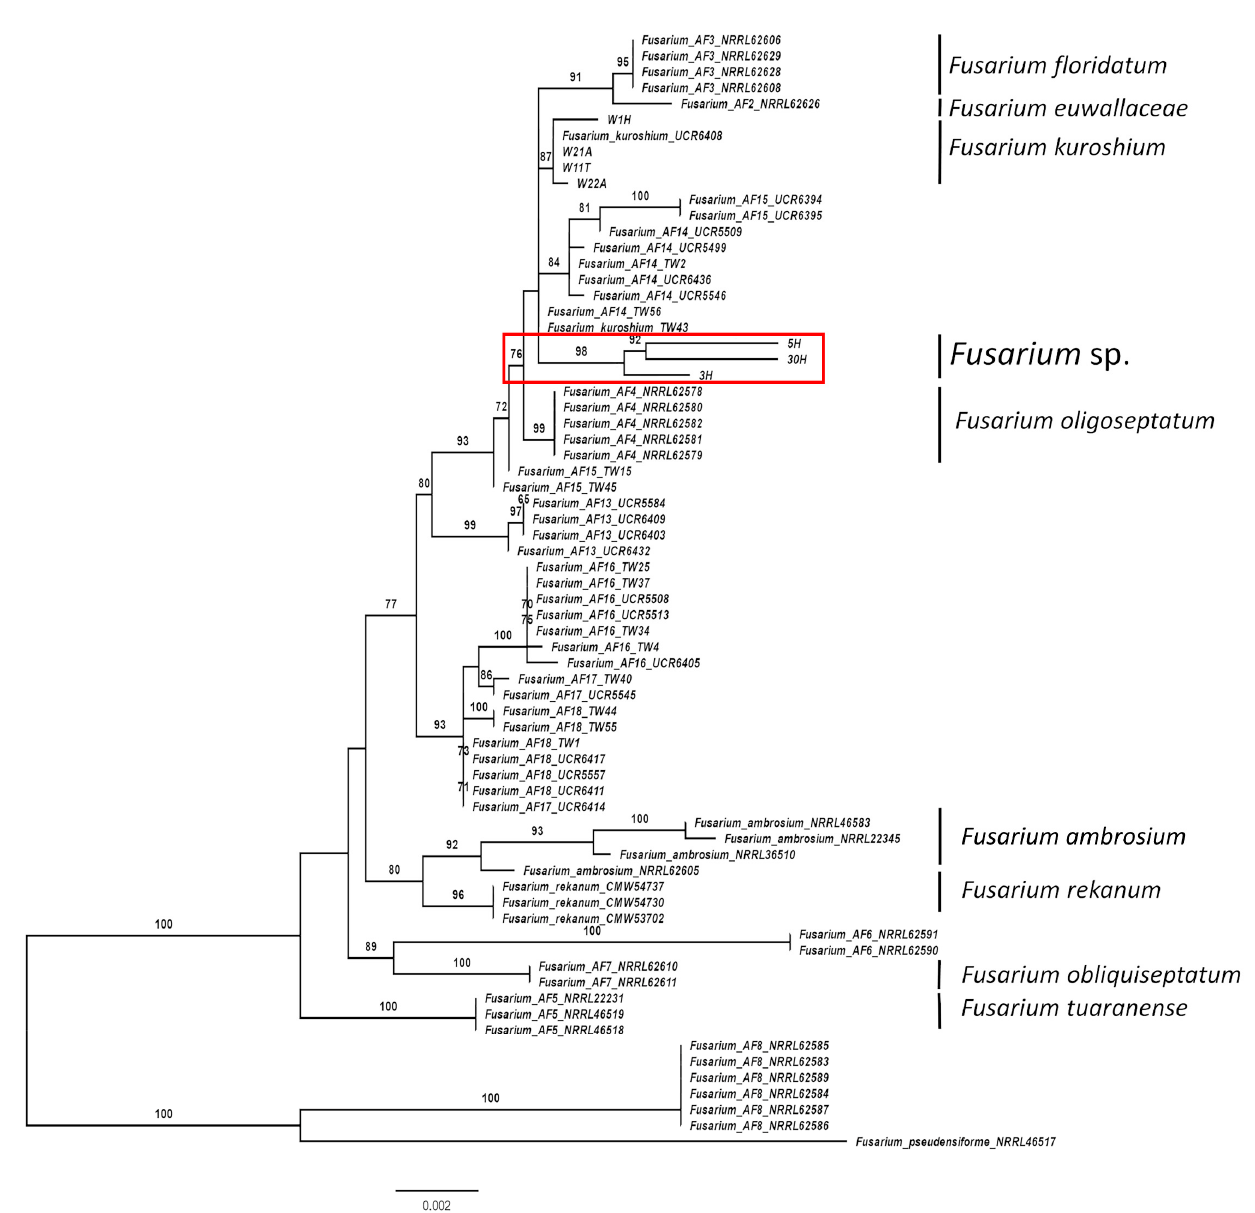
Figure 3. Multilocus phylogenetic analysis of ambrosia Fusarium clade conducted with four genes: ribosomal internal transcribed spacer, elongation factor 1-a, DNA-directed RNA polymerase II largest subunit, and DNA-directed RNA polymerase II second largest subunit. The diagram was constructed using IQ-TREE maximum likelihood method bootstrapped with 1000 replications. The red box indicates the phylogenetic placement of the Fusarium species isolated from the head including oral mycangia of the reared adults of E. interjectus .